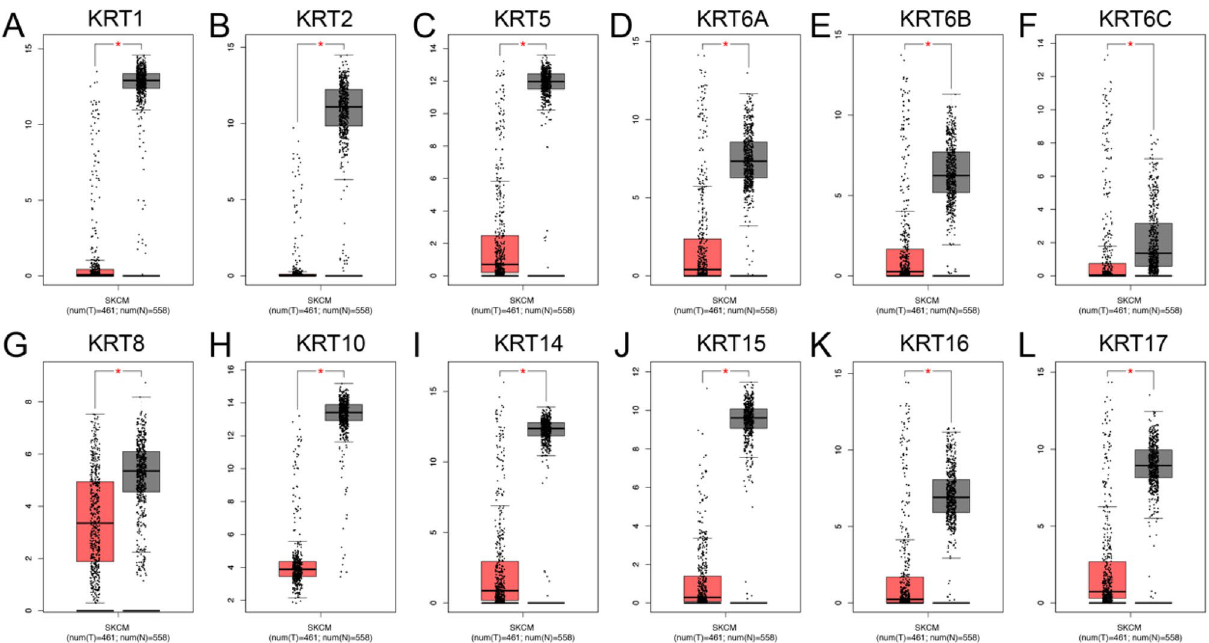
Figure 1. Transcriptional expression of distinct KRTs family members. ( A – L ) KRTs were down-regulated melanoma compared to normal skin (* P <